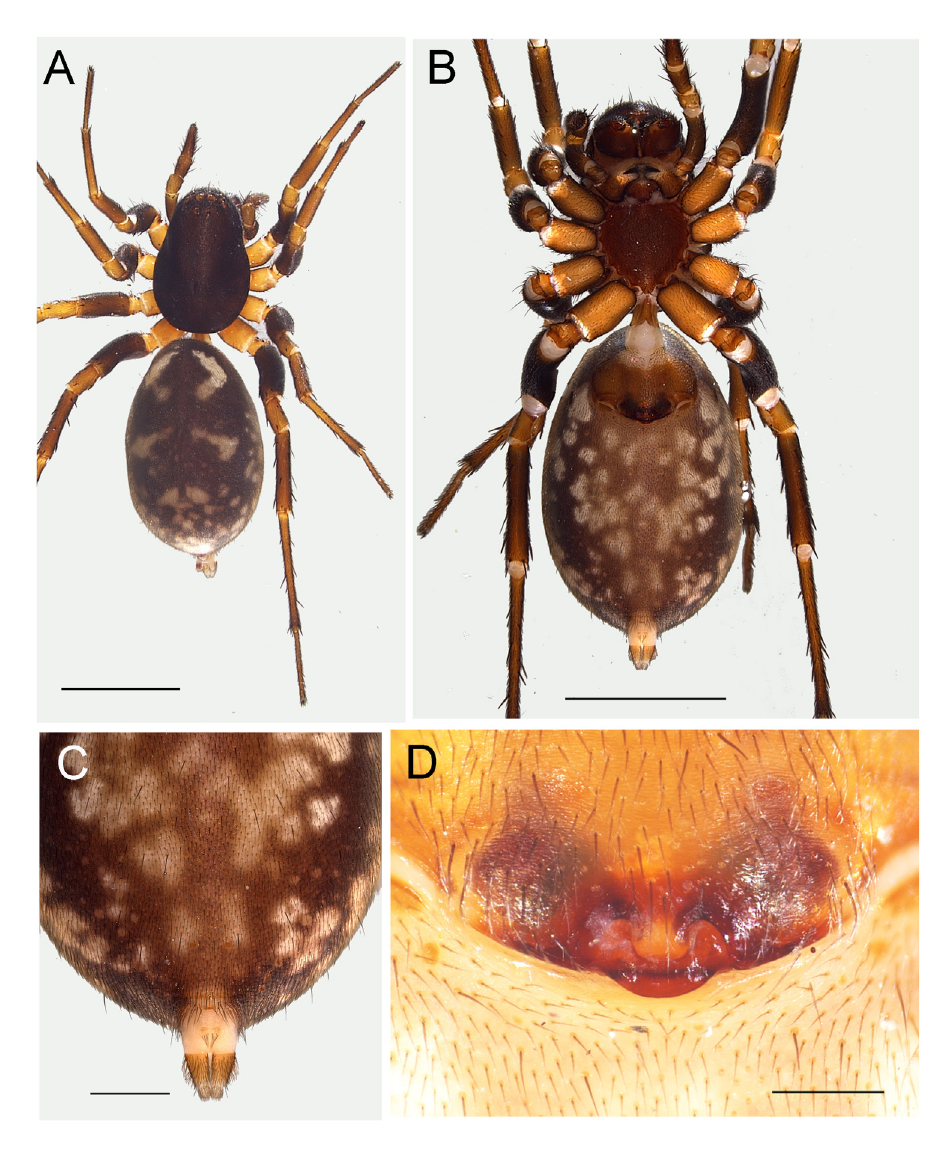
Fig. 9. Cambonilla symphonia Jocqué & Henrard gen. et sp. nov., female paratype (RBINS IG 33.889/008) A . Habitus, dorsal view. B . Habitus, ventral view. C . Abdomen, posterior part, ventral view. D . Epigyne, ventral view. Scale bars A–B = 5 mm; C = 0.5 mm; D–F = 0.2